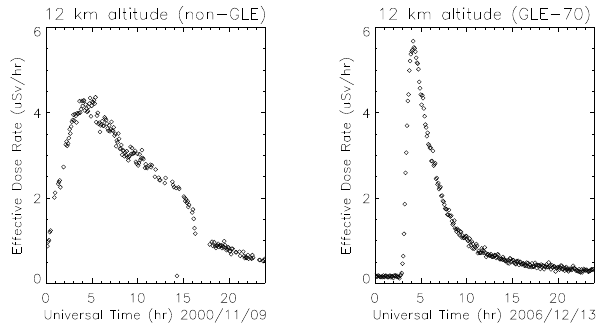
Figure 1. Examples of 5min averaged proton spectra for the non- GLE SEP event (left) and the GLE-70 event (right). Dotted lines show the energy of the pre-calculated mono-energetic protons by Sato et al. (2014).